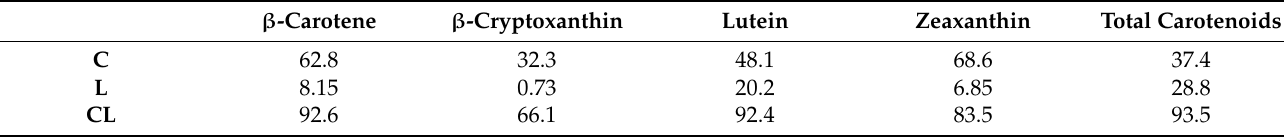
Table 3. Percentage of explanation (obtained through the coefficient of determination (R2) from simple linear regression analysis) of cultivar (C), location (L), and their combinations (CL) on amount of different carotenoids compound and for total carotenoids